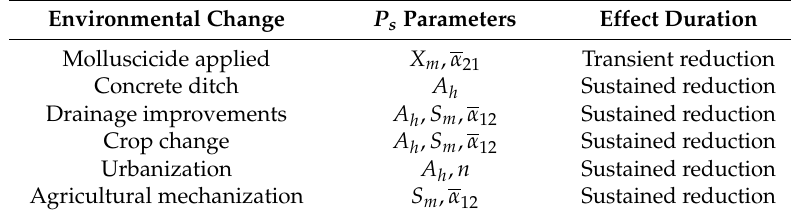
Table 1. Environmental improvements affecting determinants and effect duration of the site-specific elements of the effective reproductive number governing schistosomiasis transmission in